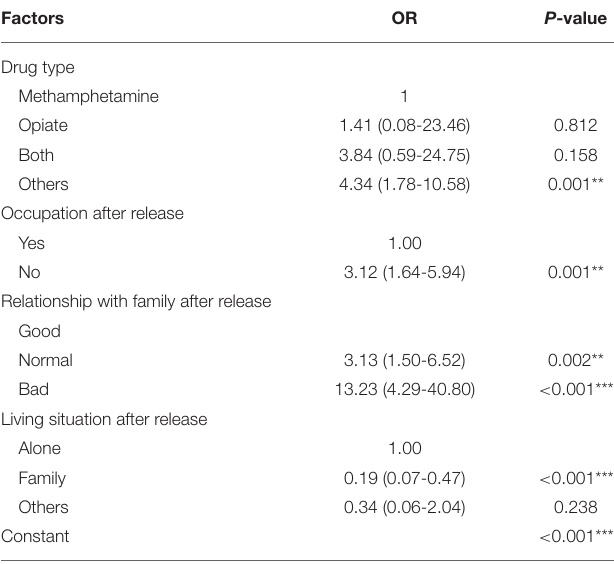
TABLE 6 | Binary Logistic regression analysis of factors to VRCs ( n = 439).